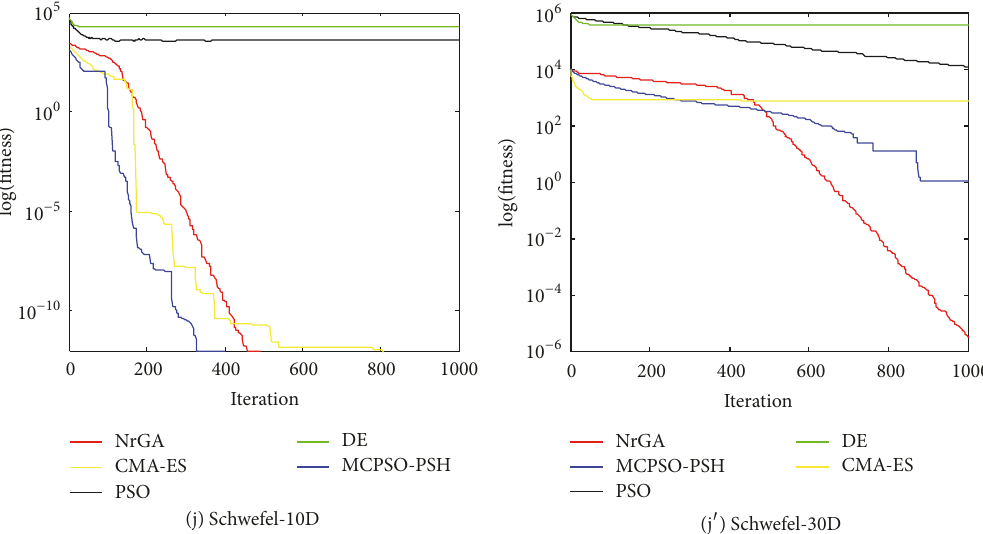
Figure 2: Convergence curves of MCPSO-PSH, NrGA, CMA-ES, PSO, and DE against test functions f 1 – f 10 in low dimension, 10D, and high dimension, 30D,